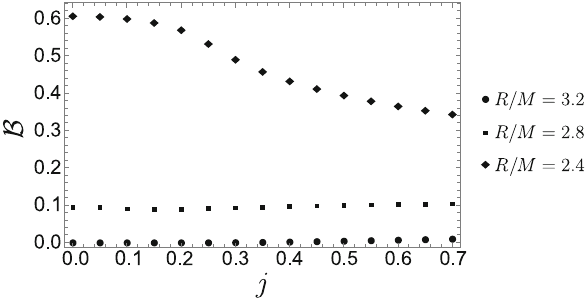
Fig. 18 The comparison of the global trapping efficiency coefficients B from Fig. 17 with the curves being shown together with the same vertical